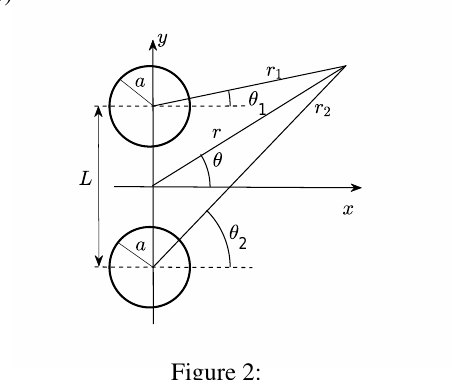
Figure 1: Two parallel dielectric cylinders (a) and coaxial disks (b).